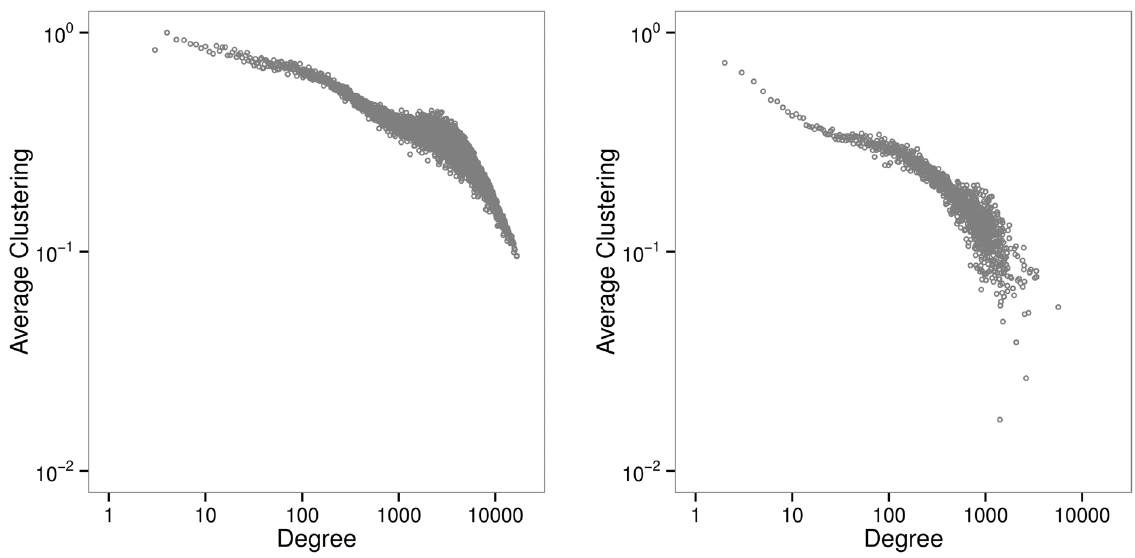
Figure 4. Average clustering per degree. Plot shows average clustering coefficient of nodes per degree for full (left figure) and major (right figure) MeSH networks. The nodes with a smaller degree exhibit higher clustering than those with larger degree. The decay can be approximated by power-law dependency.